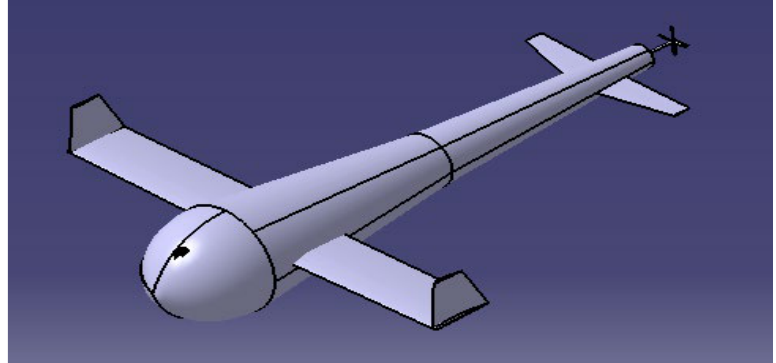
Figure 32. Design of optimised UAV—A typical view—1.